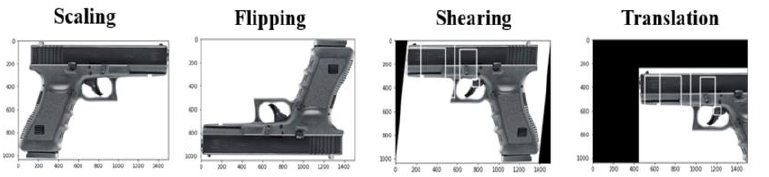
Figure 7. Data augmentation technique for dataset.